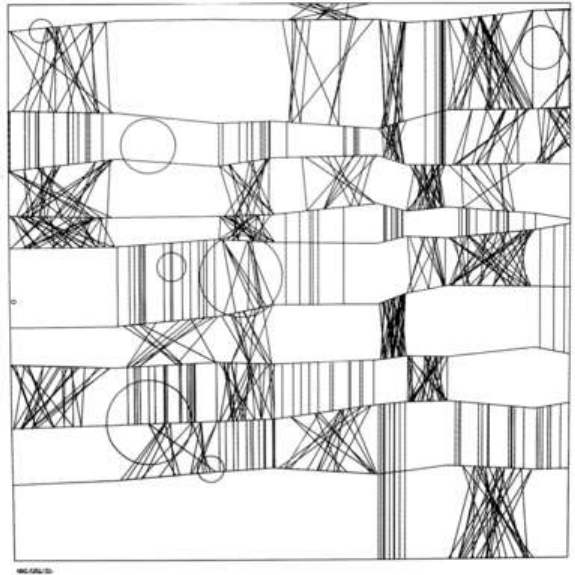
Figure 1. Homage to Paul Klee by Frieder Nake, 1965. Screenprint on paper, 49.2 cm × 49.2 cm. Victoria and Albert Museum . © Frieder Nake and used by permission.